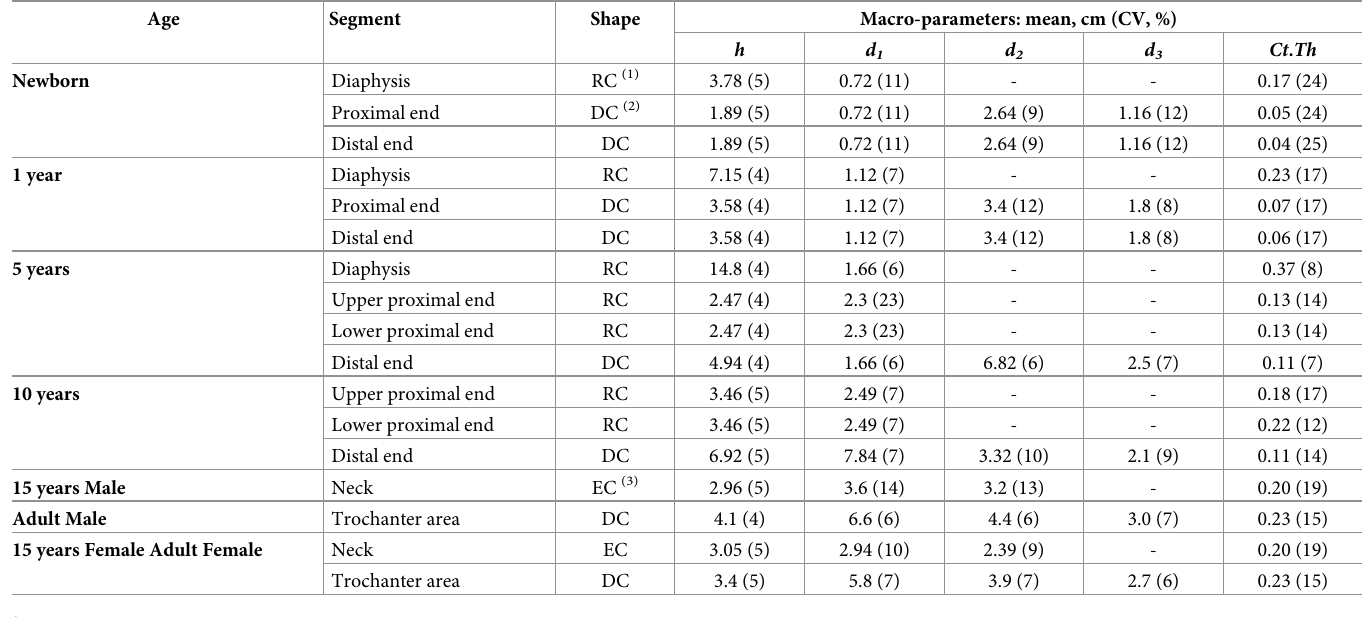
Table 5. Femur segment macro-parameters and their individual variability estimated for different ages.